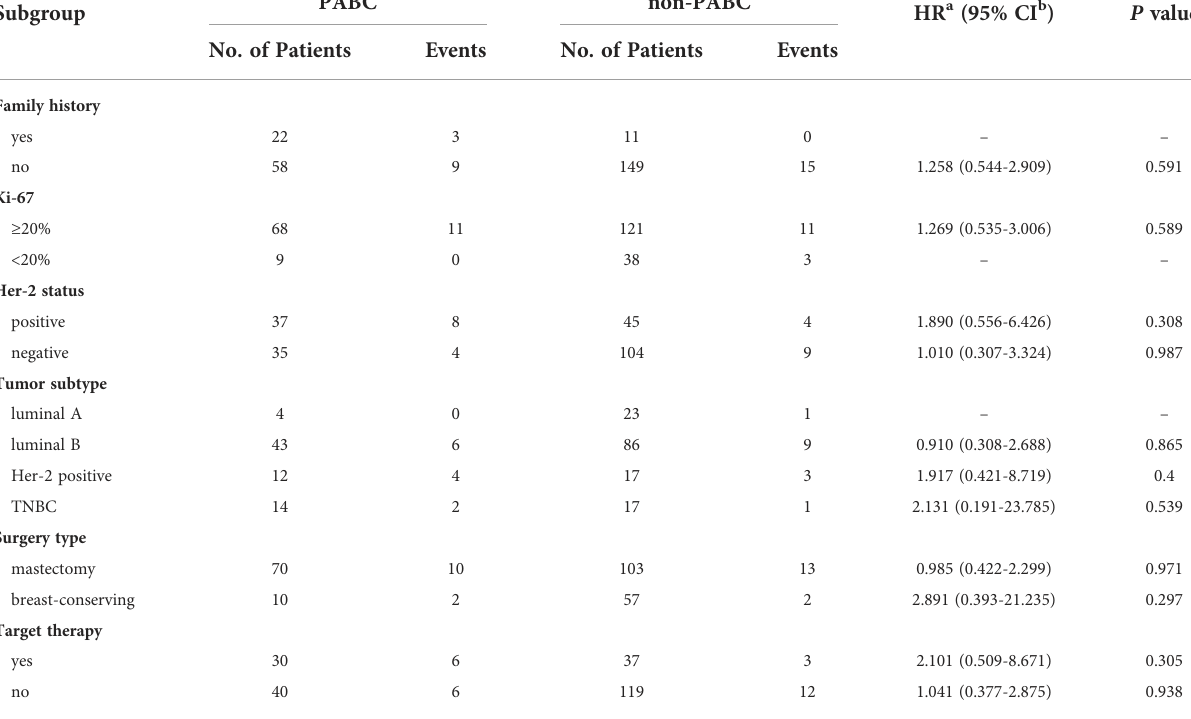
TABLE 4 Subgroup analysis of PABC patients and their